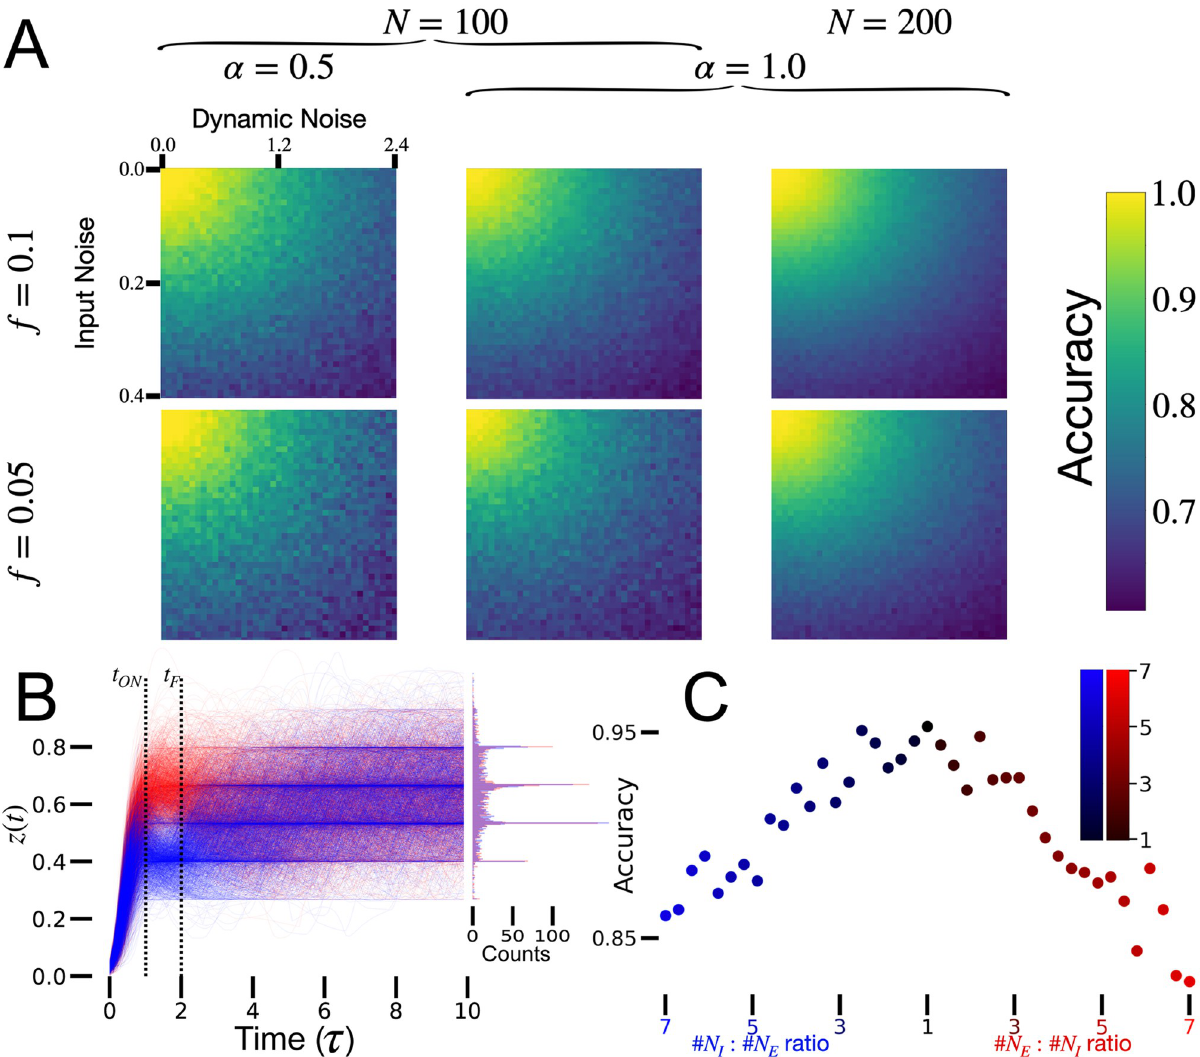
Fig 4. Robustness. A: Noise robustness heat maps for sparse RNNs. The horizontal axis indicates the level of dynamic noise, defined as the standard deviation of the dynamic noise divided by the mean of the activity in the RNN, and the vertical axis indicates the standard deviation of input noise. Sparse RNNs maintain high accuracy over a wide range of noises levels. # epochs = 150. B: Output of an example sparse RNN over time. Model is trained for 2 τ , and input is on for τ . N = 300, f = 0.05, α = 1, # epochs = 500. C: Performance of the E/I sparse RNNs as a function of the E/I ratio. N = N E + N I = 100, f = 0.1, α = 1, # epochs =